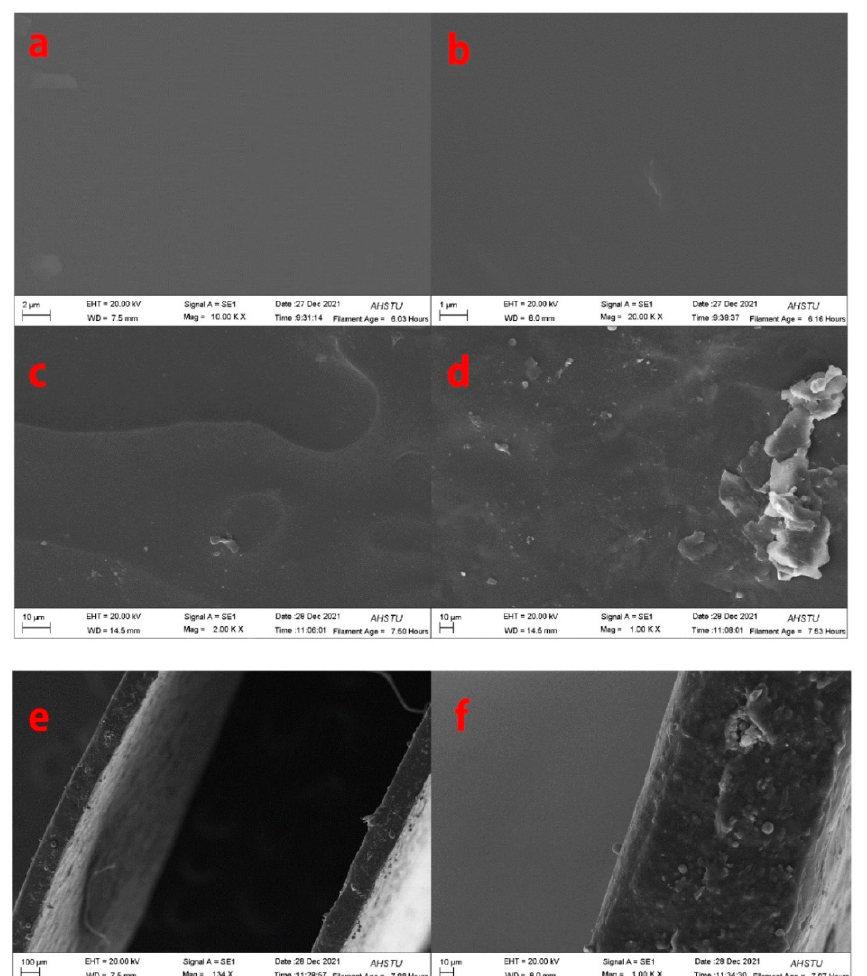
Figure 3. SEM images of surfaces for ( a ) pure gelatin film, ( b ) keratin (4%)/gelatin (10%)/glycerin (2.0%)/curcumin (1.0%) composite film, ( c ) keratin (7%)/gelatin (10%)/glycerin (2.0%)/curcumin (1.0%) composite film, and ( d ) keratin (10%)/gelatin (10%)/glycerin (2.0%)/curcumin (1.0%) composite film. The SEM images of the cross-section of ( e , f ) keratin (7%)/gelatin (10%)/glycerin (2.0%)/curcumin (1.0%) composite film.